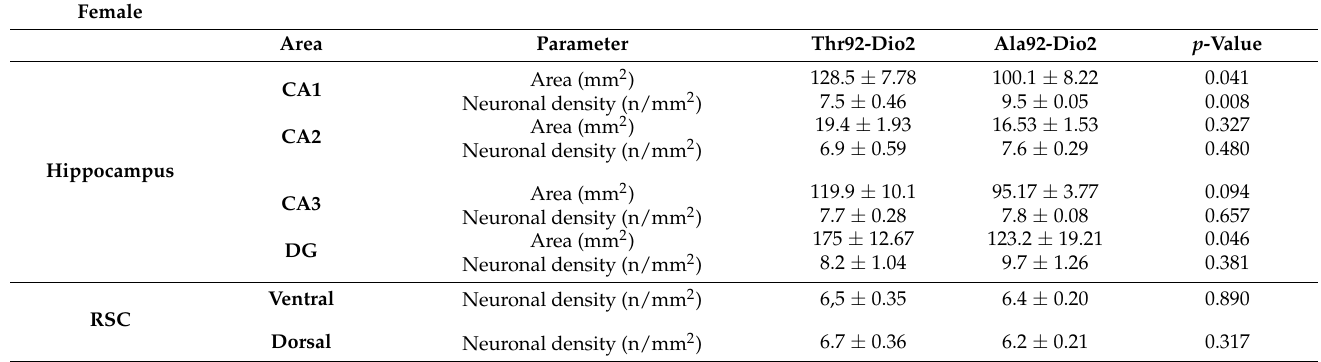
Table 5. Area and neuronal density of CA1, CA2, CA3 and Dentate gyrus (DG) hippocampal areas and retro splenial cortex (RSC) of 4-month-old female Ala92-Dio2 and Thr92-Dio2